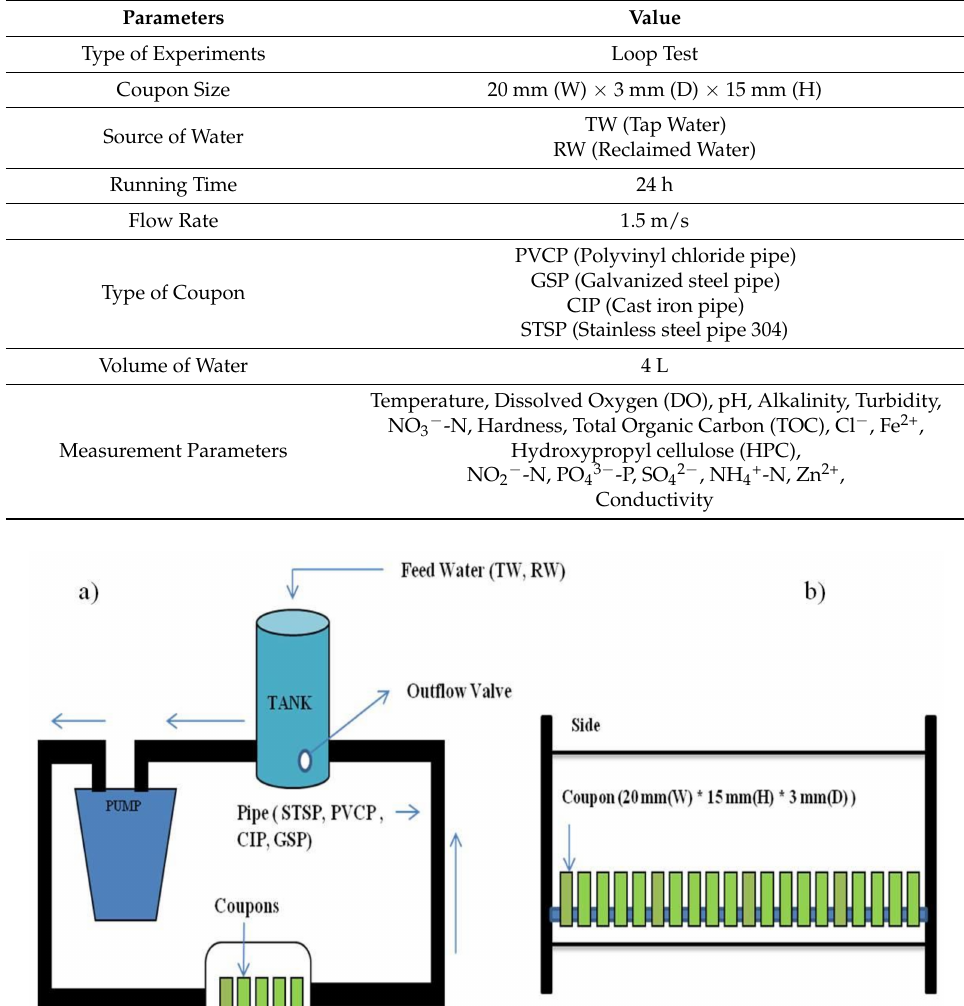
Table 1. Conditions of the simulated distribution loop system.